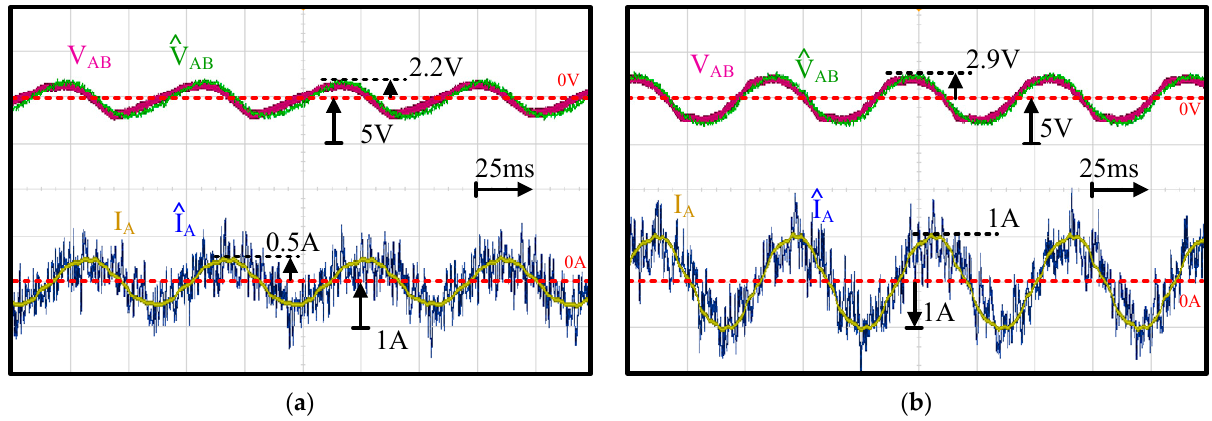
Figure 13. Experiment of estimated filter output capacitor voltage and machine current at ( a ) 25% and ( b ) 50% load (1 krpm rotor speed).